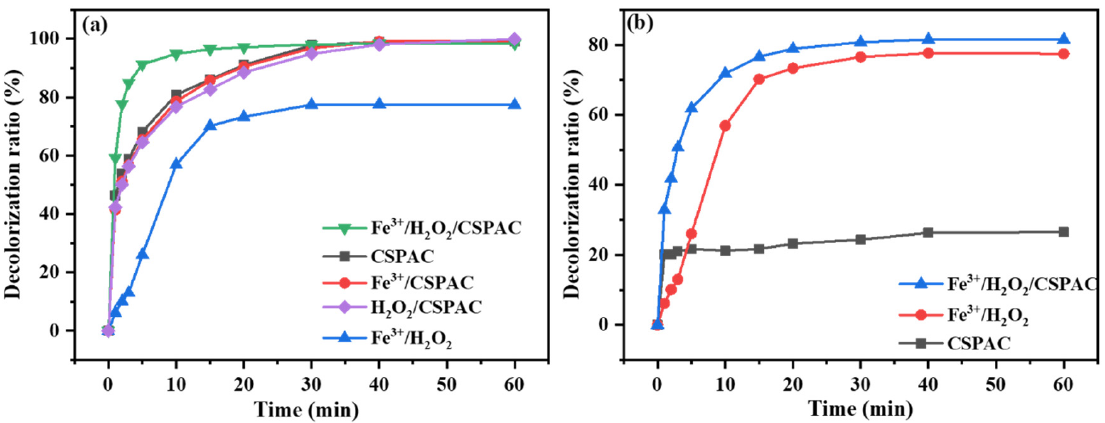
Figure 8. Decolorization rate of ARG in different systems under ( a ) untreated and ( b ) adsorbed saturated CSPAC conditions (0.1 mmol/L FeCl 3 , 0.4 mmol/L H 2 O 2 , 100 mg/L ARG, 0.6 g/L CSPAC (75 µ m particle size), pH = 3).